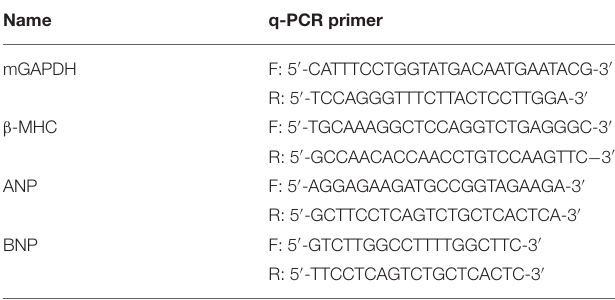
TABLE 1 | The primer pairs used for real-time